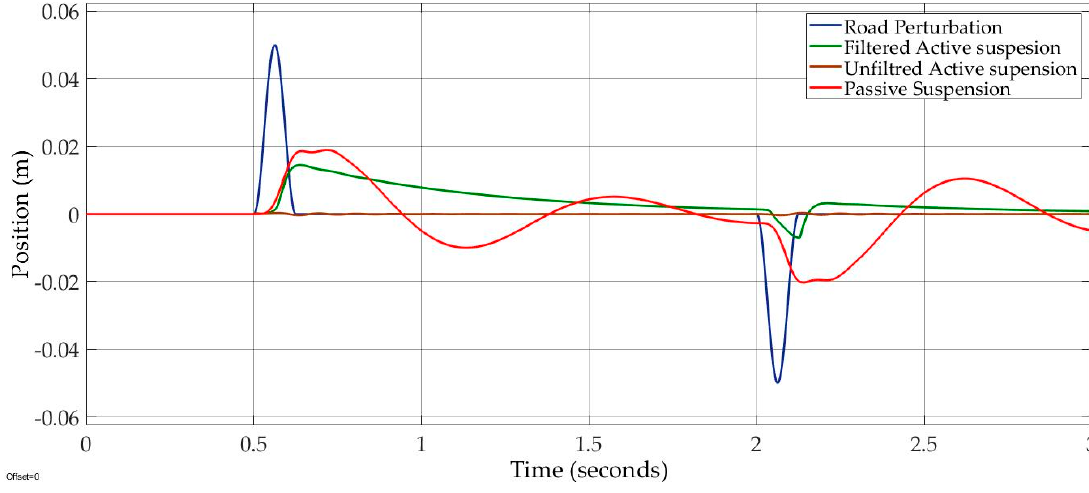
Figure 11. Sprung mass position of Case 2.